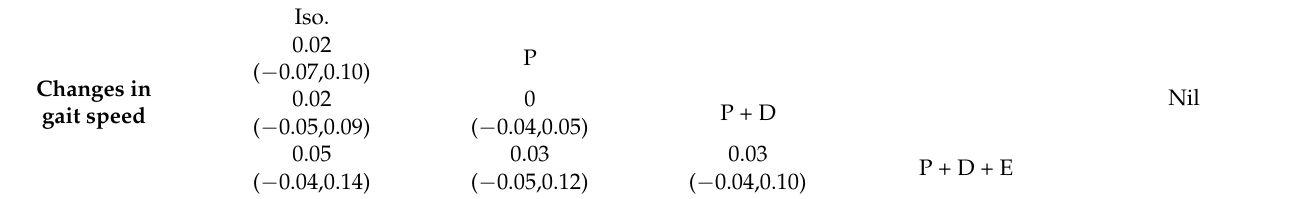
Figure 3. Forest plots of ( A ) change in hand grip and ( B ) time to chair-stand test, and ( C ) rainbow plot of P-scores. CI, confidence interval; D, vitamin D; E/Ex, exercise; Iso, iso-caloric product; P, protein; RSMI, relative skeletal muscle index; WMD, weighted mean difference. Table 2. League table of network meta-analysis findings. Mean difference (95% confidence